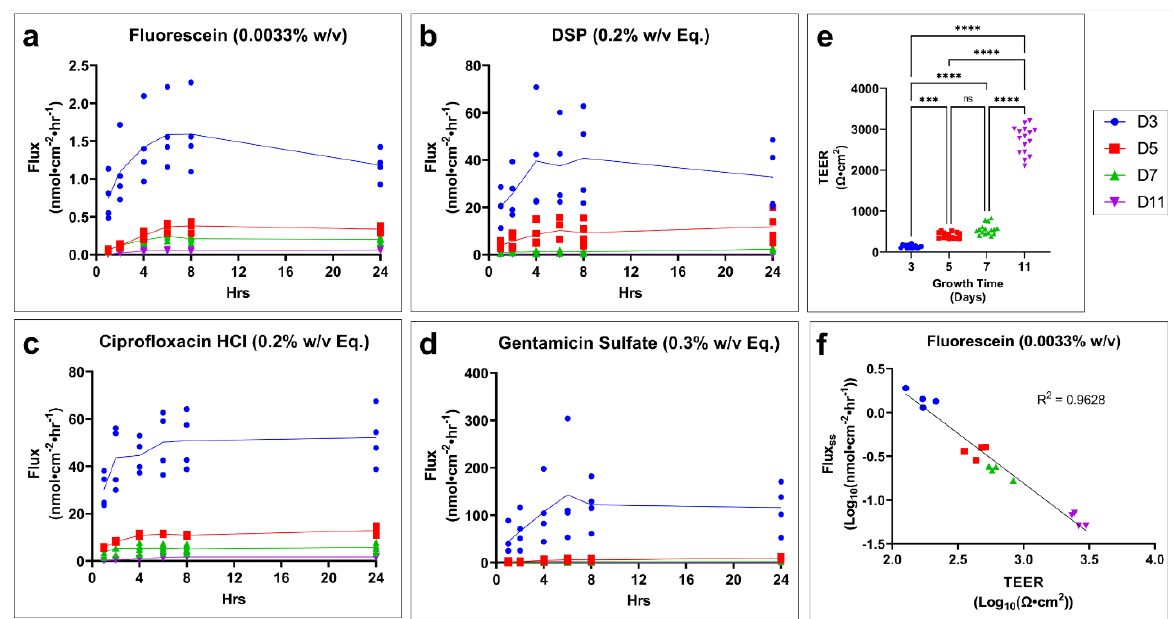
Figure 3. Tissue growth time has a significant effect on TM model drug permeation and TEER. Drug flux of profile over time for ( a ) fluorescein, ( b ) DSP, ( c ) ciprofloxacin HCl, and ( d ) gentamicin sulfate grown for 3, 5, 6, or 11 days. n = 3–4. ( e ) Effect of growth time on the TEER of tissues. n = 15–16. One-way ANOVA with Tukey’s correction for multiple comparisons; *** p < 0.001, **** p < 0.0001 ( f ) Example of correlation between fluorescein flux at steady state (flux ss ) and TEER after log transformation. n = 4 (16 total). Legend applies to all panels. DSP, dexamethasone sodium phosphate; Eq, molar equivalent of base compound; TEER, transepithelial electrical resistance; TM, tympanic membrane; w/v, weight by volume; ns, not significant.